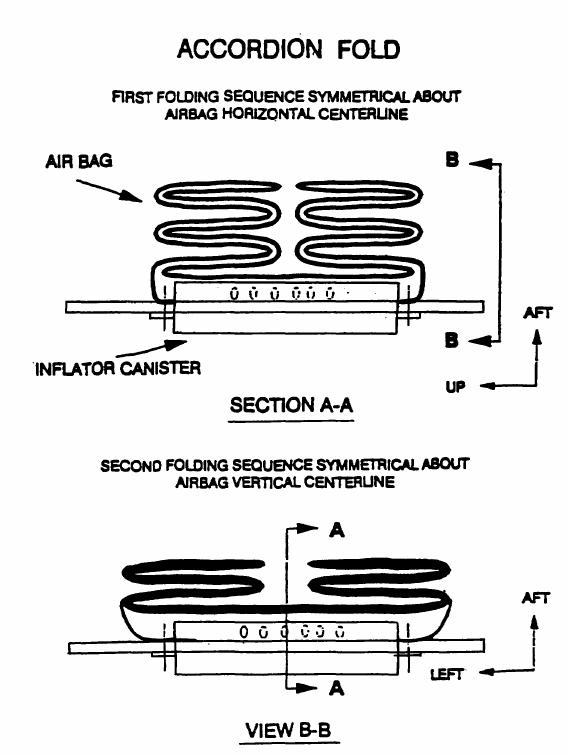
FIGURE 1 Sectional view of an accordion folded